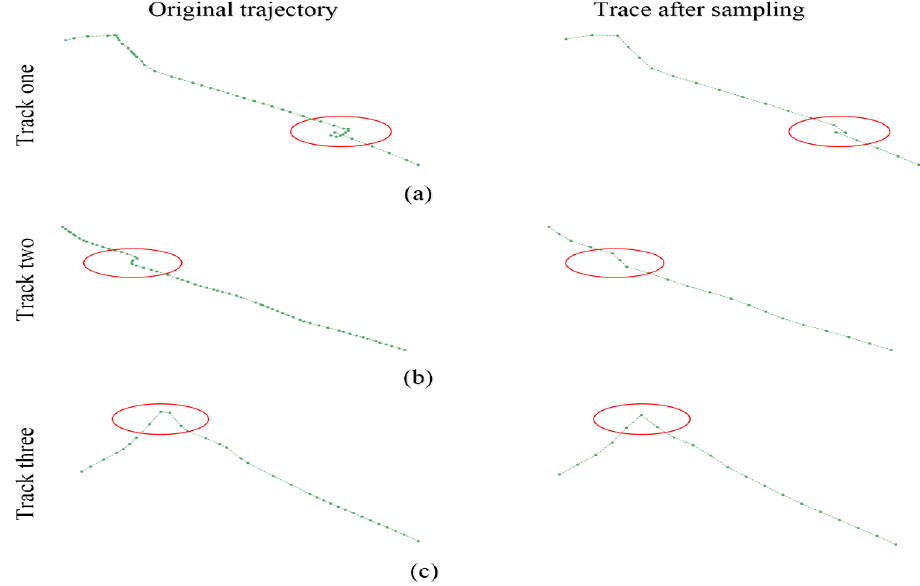
Figure 2. Three different types of original and sampled trajectories. ( a , b ) the 20 ship trajectory points; ( c ) the ship in the original trajectory.